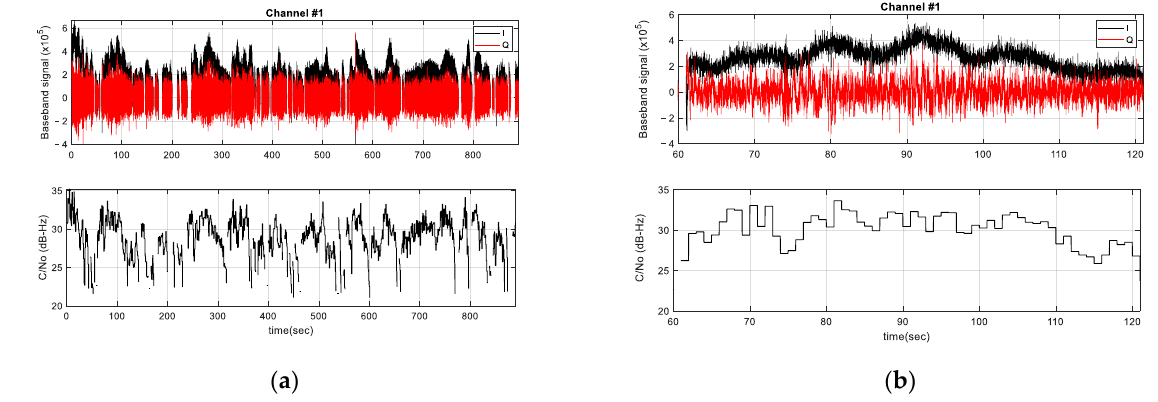
Figure 5. ( a ) Baseband signal (Phase arm (I) and Quadrature arm (Q)) and estimated C/No of the successively received satellite tones; ( b ) Zoom in showing a low signal level at the start and end times of satellite tracking, a high signal envelope at high satellite elevations, and a signal amplitude oscillation at low frequency (~0.1 Hz).